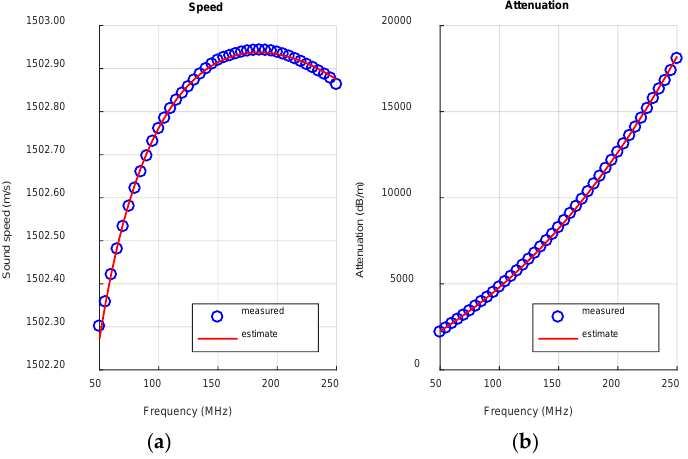
Figure 2. ( a ) Measured and estimated fit of the speed of sound and ( b ) attenuation for a dispersion containing standardized silica particles with a mean diameter around 484 nm and a weight concentration of 5 w %.